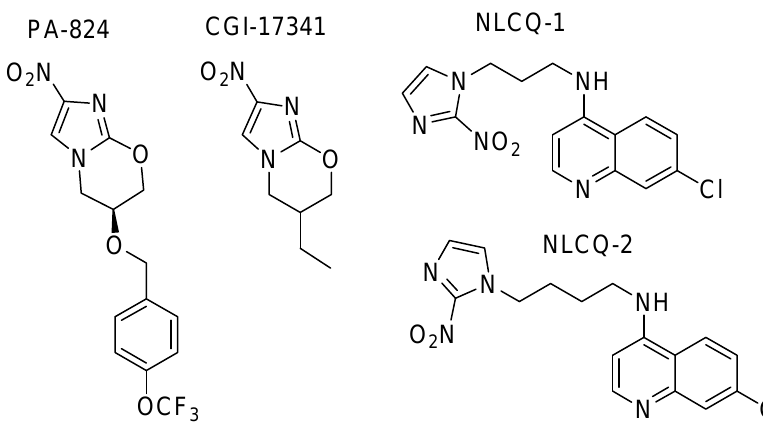
Figure 36. Chemical structures of nitroimidazole